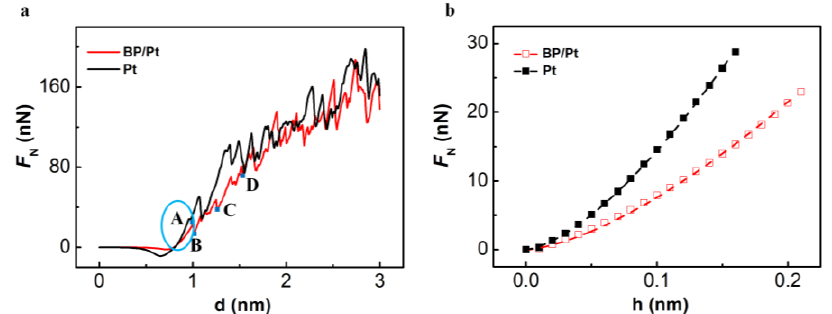
Figure 3. ( a ) The force-displacement ( F N ( d )) curve for the indentation process of Pt and BP/Pt substrate; ( b ) The force displacement curve at elastic stage (corresponding to the blue ellipse in Figure 3a), and the dashed line is a nonlinear fit of Formula (2).